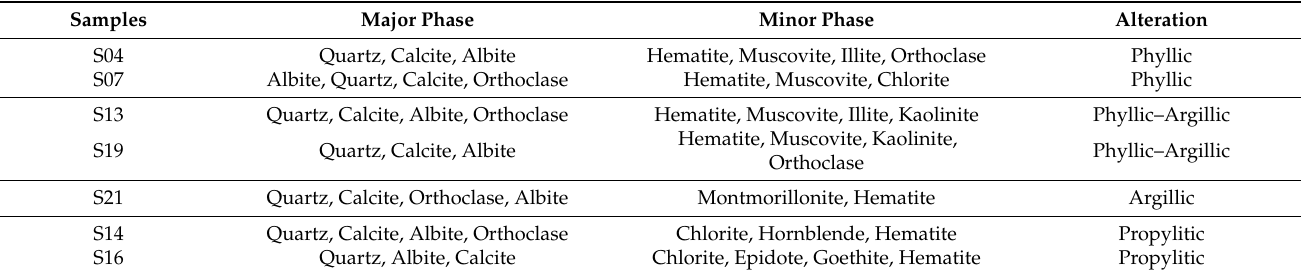
Table A3. The results of the XRD